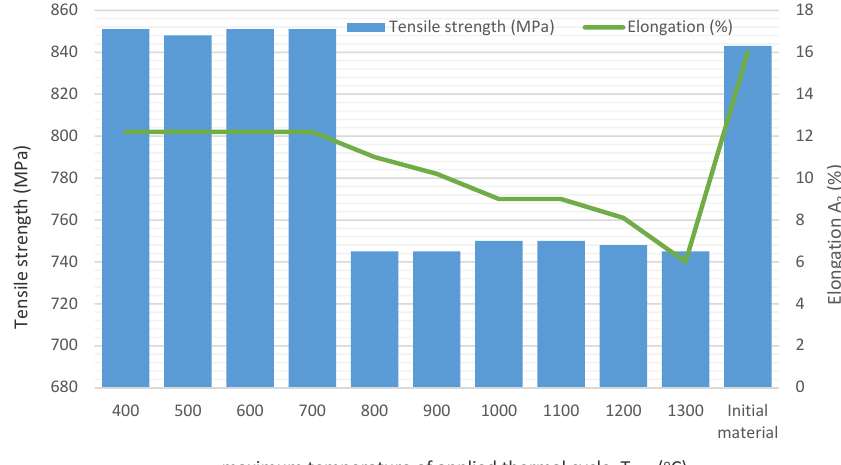
Figure 20. Tensile strength and relative elongation of steel S700MC thermo-mechanically simulated HAZ in dependence of the maximum temperature of applied thermal cycle.